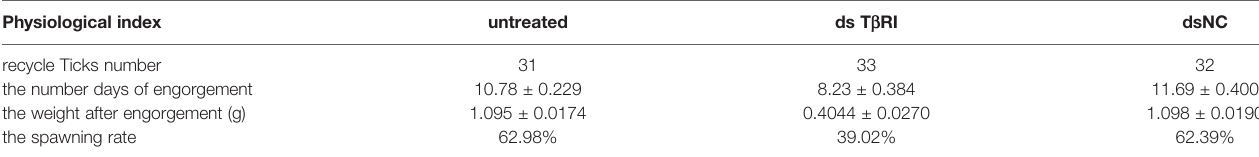
Each data point is the mean ± SEM of three independent experiments (n = 3). Different letters on the same line indicate signi fi cant differences (P <